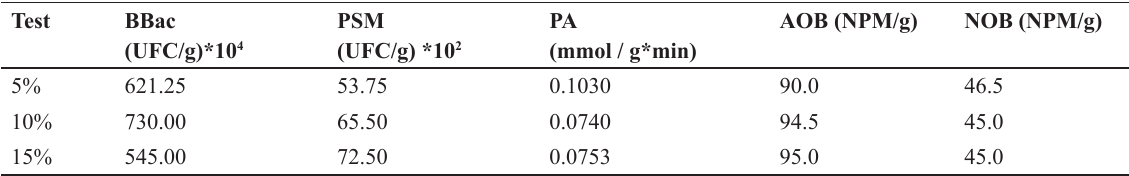
Table 1 Microbiological activity and phosphatase of the composting of manure C: E: P mixture with different PR concentrations